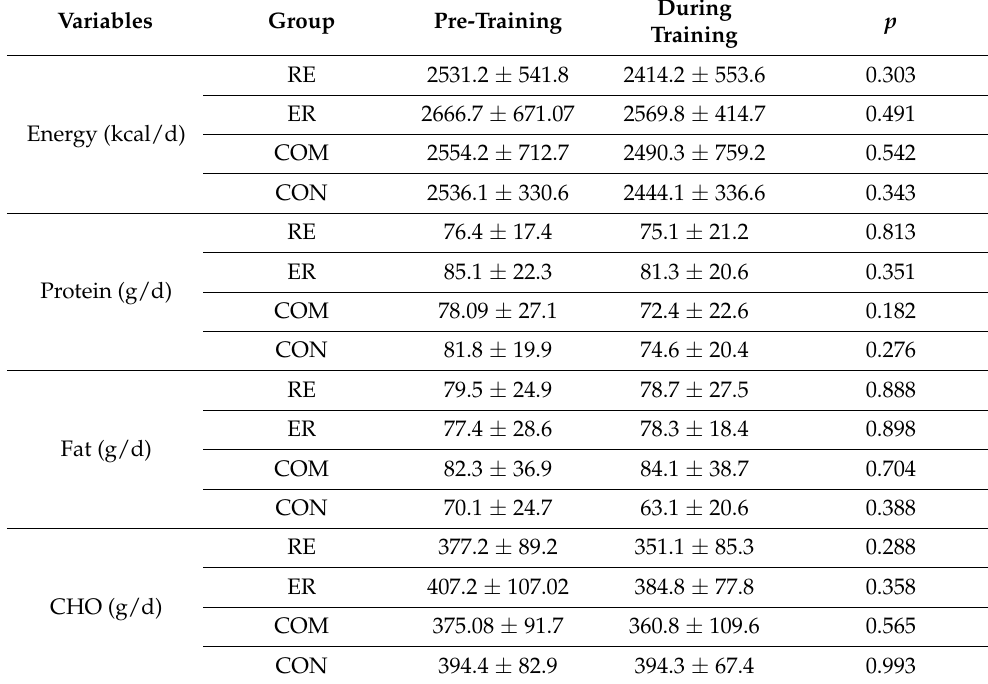
Table 2. Energy and macronutrients at baseline and during 12 weeks.